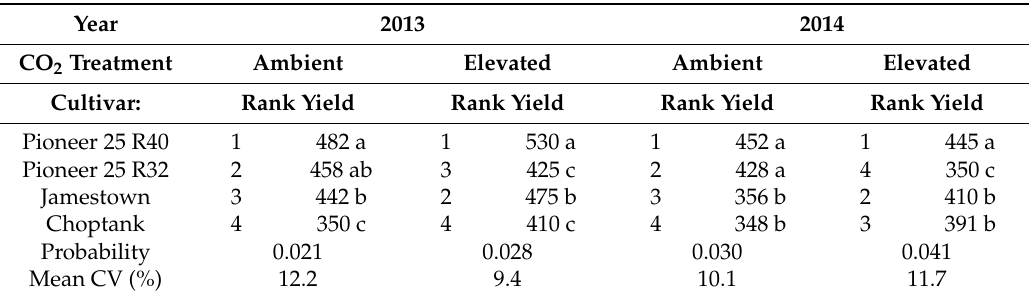
Table 1. The mean seed yield (g dry mass m − 2 ) and the ranking of mean yield of four wheat cultivars grown at elevated and ambient CO 2 in 2013 and 2014; the probability of significant differences in yield within a year and CO 2 treatment; and the mean coefficient of variation (CV). Within columns, values followed by different letters were significantly different at p = 0.05, by